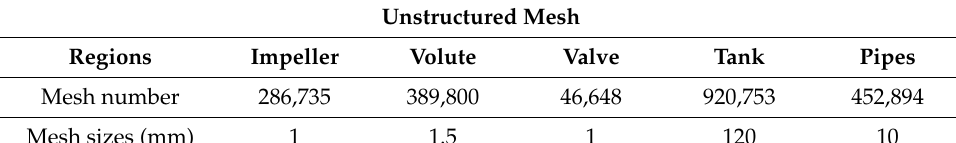
Figure 11. The numerical model for the pump and ball valve. Table 2. Overview of the mesh in the numerical model.